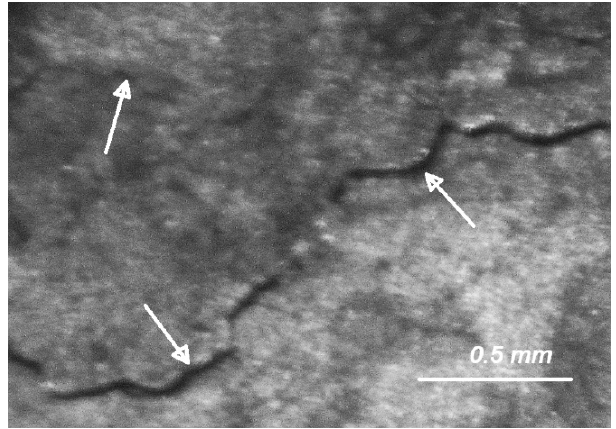
Figure 14. Brittle intercrystalline cracking caused by hydrogen diffusion stimulated by short ‐ term cathodic polarization phenomena.